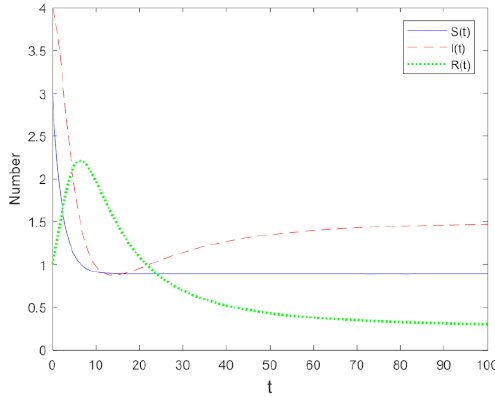
Figure 4. The stability of the equilibrium point E 4 .